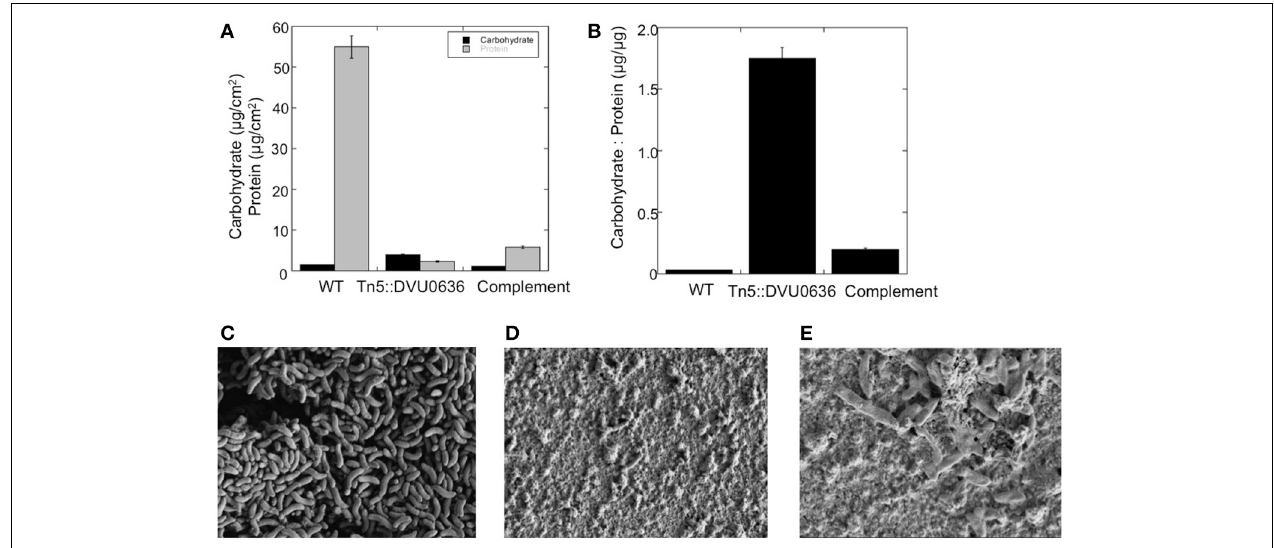
FIGURE 9 | Inactivation of DVU0636 affects biofilm formation. (A) The carbohydrate (black) and protein (gray) measurements for WT, Tn5::DVU0636 mutant and complemented strains. Measurements for carbohydrate and protein levels were measured in triplicate for biological duplicates. Error bars indicate standard error of the mean. (B) The carbohydrate to protein ratio ( μ g